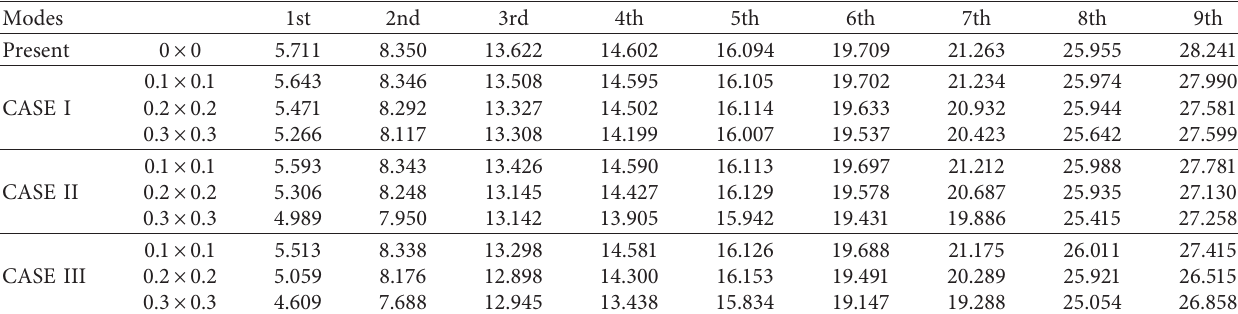
Figure 3: Modal shapes of the cross-ply laminate ([90/ − 90]s) with single patch (CASE (I) 0.3 × 0.3) on the composite substrate and CCCC boundary condition by the FEM. Table 2: Nondimensional frequencies of the cross-ply laminate ([0/90]s) with CCCC boundary condition, E 1/ E 2 � 20, and a � b � 10h and for different patch sizes and